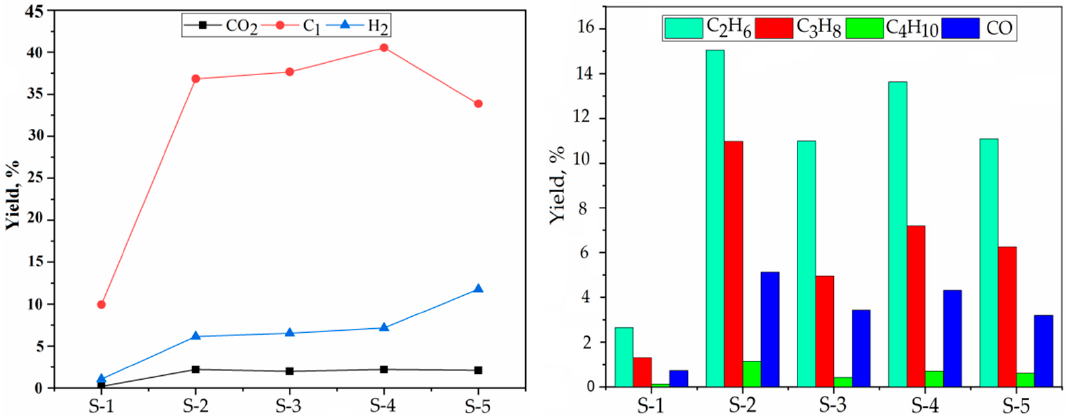
Figure 1. Yield of hydrogen after hydrothermal upgrading of extra-heavy oil.